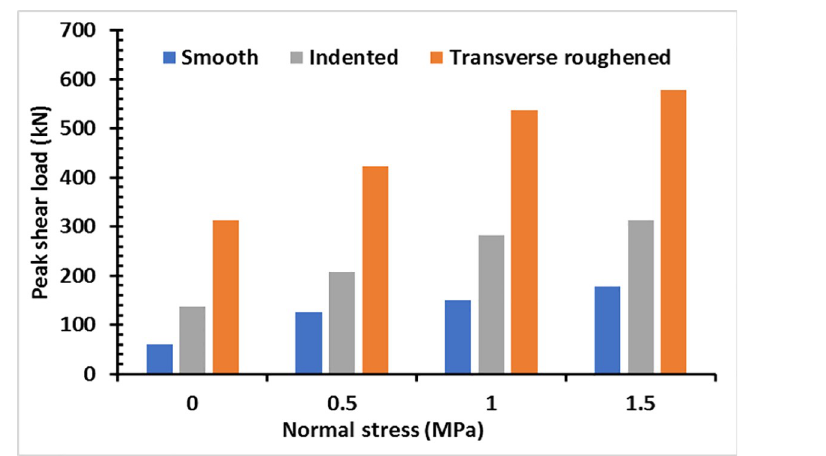
Fig 9. Peak shear loads of various interfacial conditions under different normal